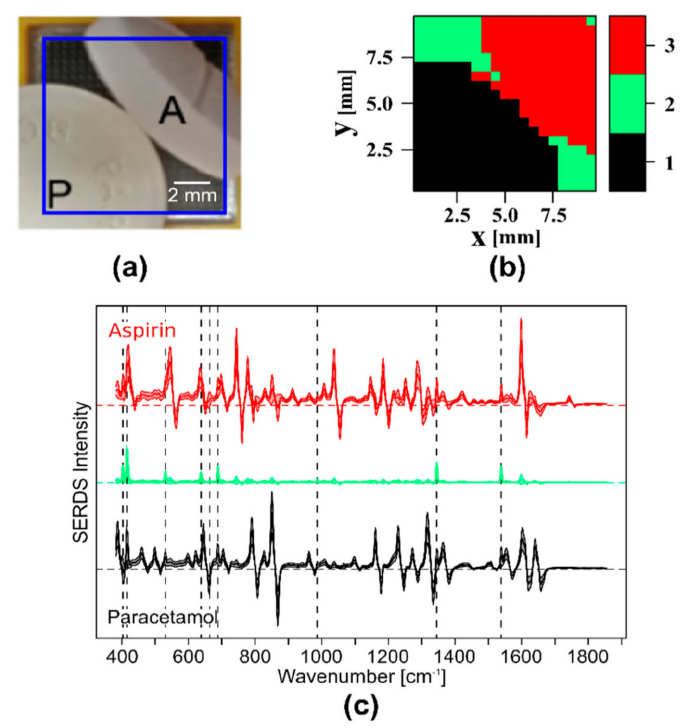
Figure 5. SERDS imaging using nod and shu ffl e of a paracetamol (P) and an aspirin (A) pill with an acquisition of 200 times 200 ms. ( a ) Picture of the sample on the probe head, the blue square corresponds to the field of view; ( b ) cluster map of the SERDS image; ( c ) clustered mean SERDS spectra and their standard deviation, cluster 1 = paracetamol (black), cluster 2 = no sample / residual room light (green), cluster 3 = aspirin (red); the dotted, vertical black lines indicate the position of the room light